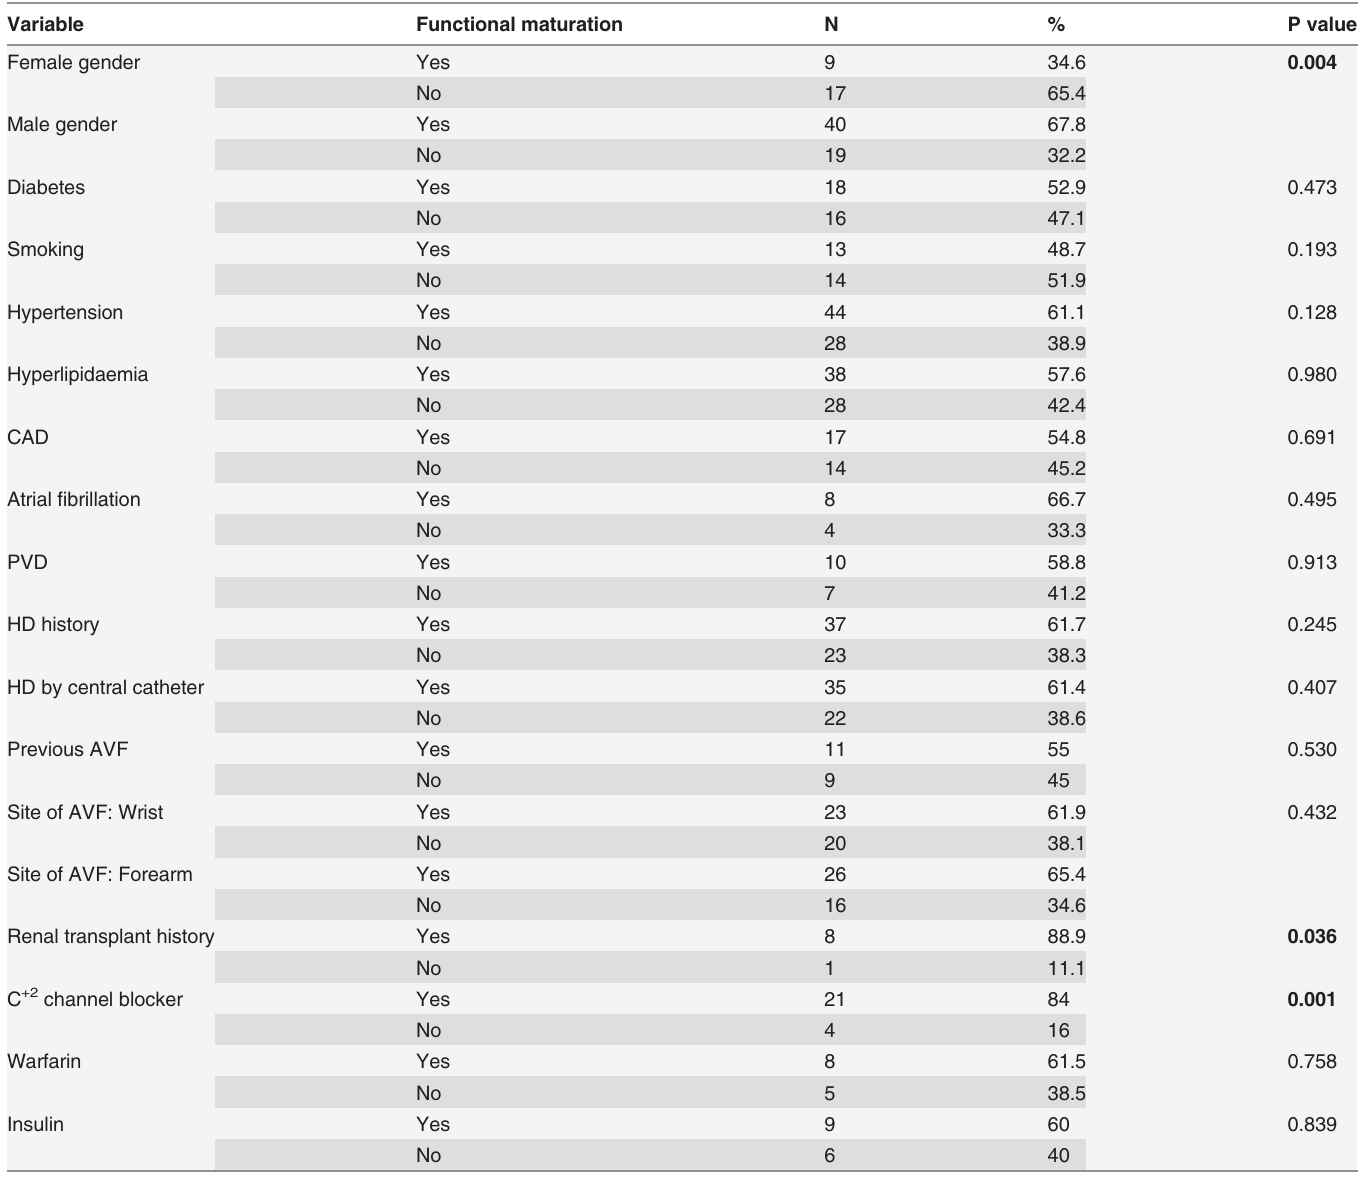
Table 3. Categorical variables association with functional maturation. Variable Functional